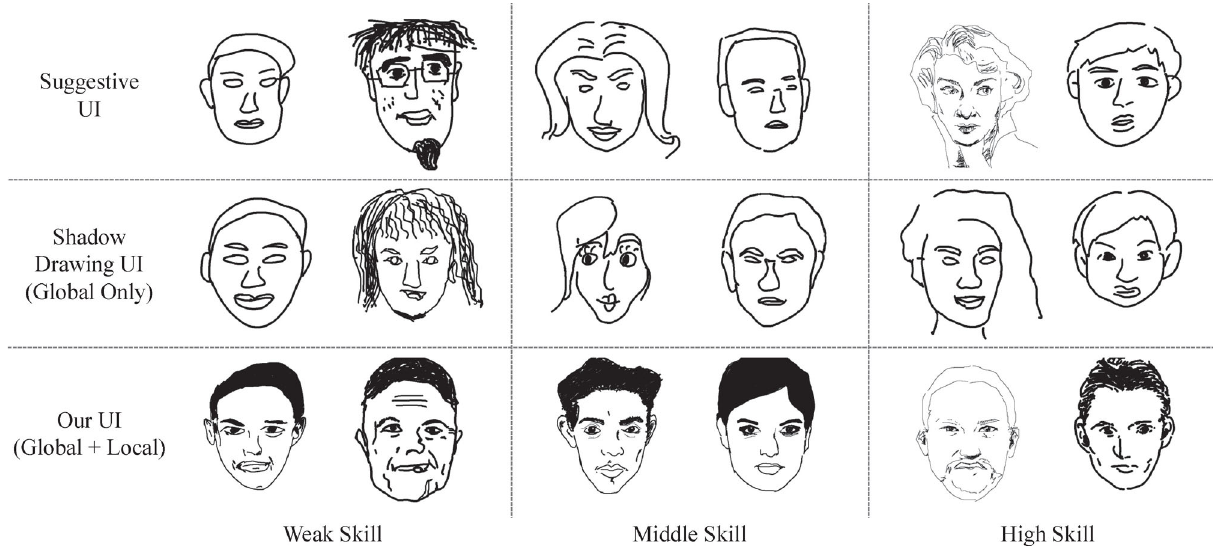
Fig. 10 Drawing results from six participants. Each column corresponds to the same participant’s